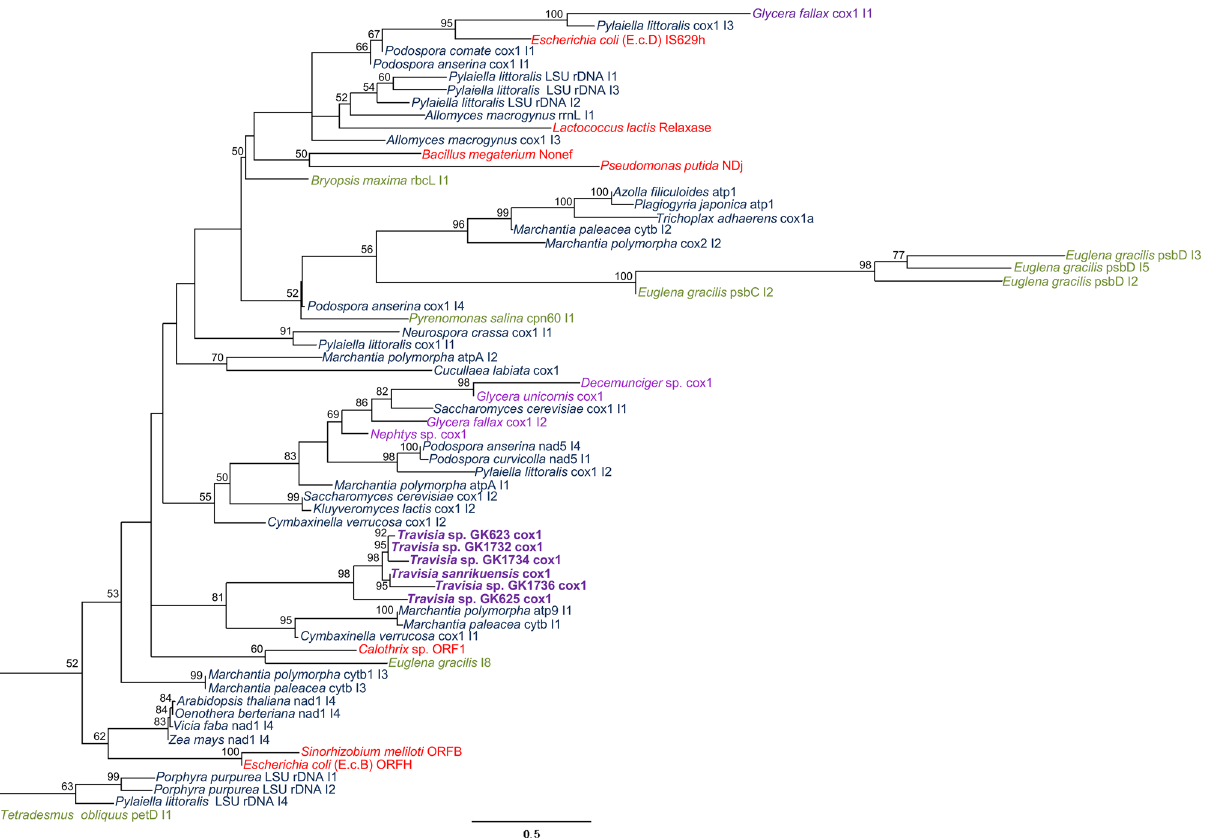
Figure 4. Maximum likelihood phylogeny of group II intron based on the nucleotide sequences of domain V and subsequent sites. The percentage of maximum likelihood bootstrap values (BS) ≥ 50% is shown above branches. Scientific names are followed by the host gene and intron ID. Bacterial group II introns (red), chloroplasts (green), and mitochondrial (blue) group II introns are included in the analysis. Annelid mitochondrial introns are shown in purple. OTUs with newly obtained sequences are in